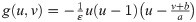
The fundamental structure of periodically rotating spiral wave.(a) A periodically rotating spiral wave is introduced in a two-dimensional (2D) regular excitable lattice containing 50 × 50 nodes at diffusion coefficient D = 4.0. Other system parameters are kept throughout this paper as a = 0.84, b = 0.07 and ϵ = 0.04. The figure is plotted in greyscale from black (lowest value at 0.0) to white (highest value at 1.0). And this greyscale will be used throughout this paper. The white arrowed line indicates the rotation direction of the spiral wave. (b) The tip trajectory of spiral wave (a). In present paper, spiral tip is defined to be the intersection of the two contours u = 0.50 and v = 0.35. Here v = 0.35 is calculated according to the formula: g(u = 0.50, v) = 0, where g(u,v)=-1εu(u-1)(u-v+ba) is the local dynamics of variable u. (c) The dominant phase-advanced driving (DPAD) pattern corresponding to the spiral wave (a). The red dots represent the nodes in the 2D regular excitable lattice, and the black arrowed lines denote the wave propagation paths. (d) The local amplified DPAD pattern of the black rectangular area in (c). The index, such as the (21, 28), represents the node position in the 2D regular excitable lattice with x = 21 and y = 28. The fundamental structure of periodically rotating spiral wave, which contains the loop structure and the wave propagation paths, is revealed by the DPAD analysis method clearly.